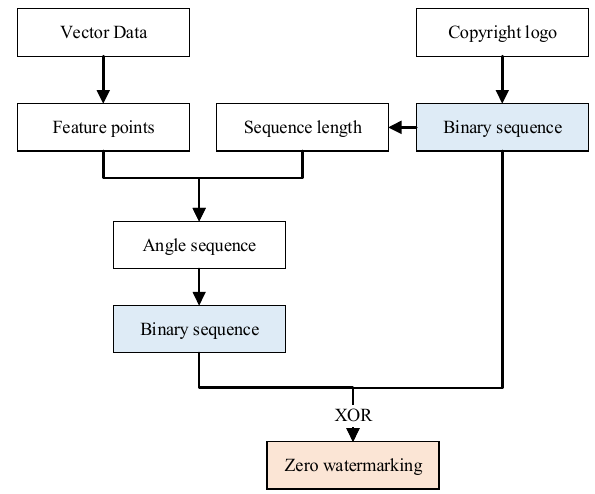
Figure 1. Zero watermarking construction process.